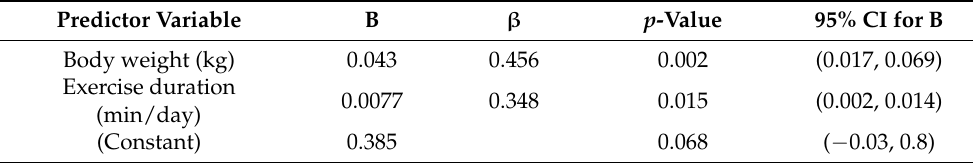
Table 4. Regression analysis for predicting WT